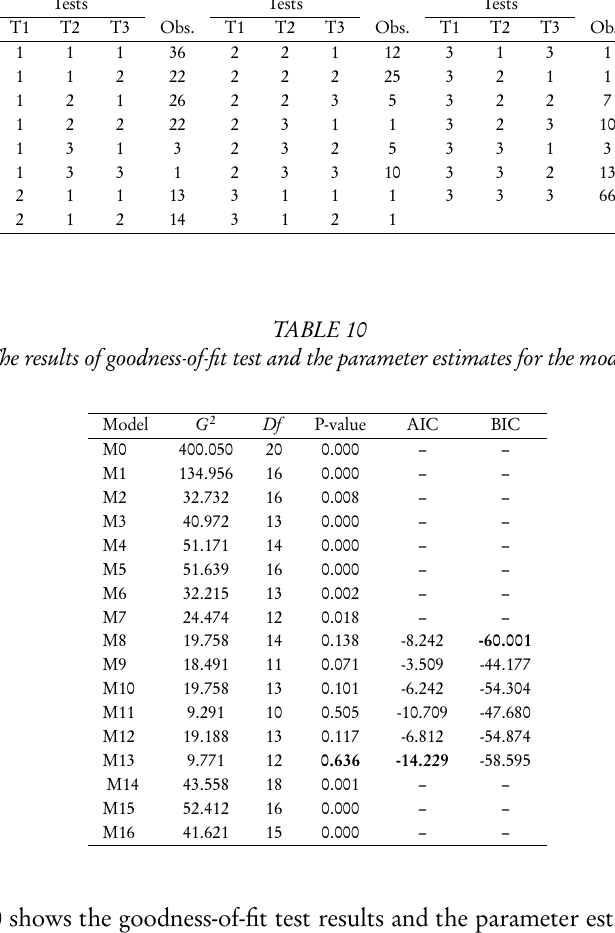
M16. According to the presented results, only seven of seventeen models fit the data. The models with uniform association parameters do not fit the data. In that case, non- uniform association plus agreement models are good alternatives to uniform ones.